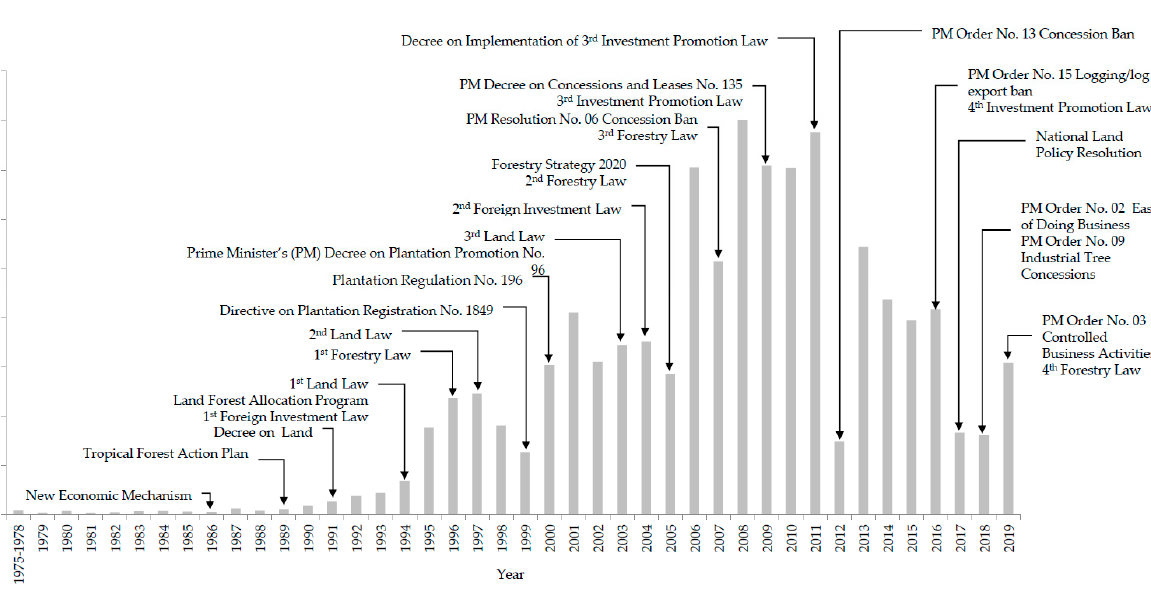
Table A1. Chronology of key forest-related policy initiatives or measures in Laos.